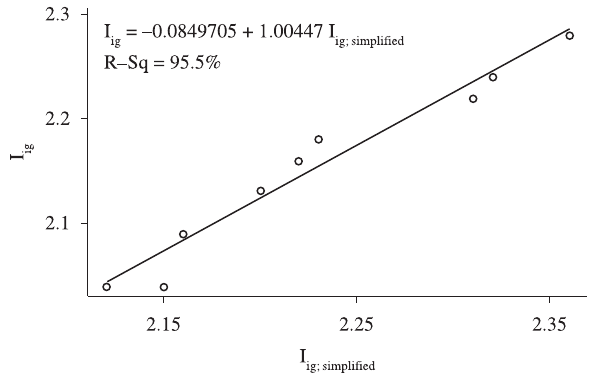
Figure 12. Regression between I values of I . ig